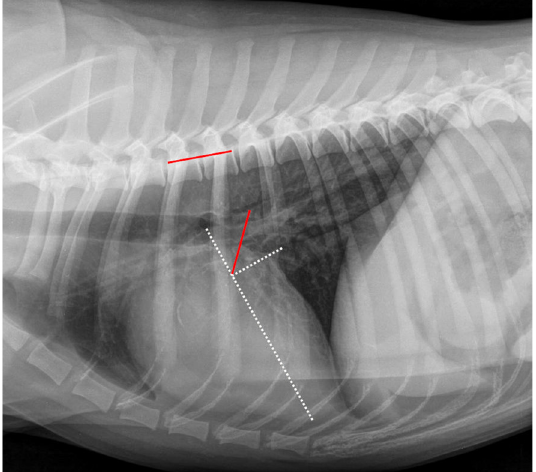
Figure 2. Measurement example of RLAD. Radiographic Left Atrial Dimension (RLAD) measurement in the same right lateral thoracic radiograph is seen in Figure 1. The long axis (white dotted line) was applied as described for the VHS measurement (Figure 1). The short axis (white dotted line) was drawn from the dorsal intersection of the caudal vena cava and the cardiac silhouette to the long axis. The bisecting RLAD line was drawn from the intersection point to the dorsal margin of the left atrium (red line on cardiac silhouette). This line was transposed onto the vertebral column (red line on vertebral) as described in Figure 1. The RLAD was 1.8 vertebral units. The LA Width was measured as described by Stepien et al. (2020) [26] and is shown in Figure 3. As a basis for measuring the RLAD, two axes had to be drawn similarly as described for the VHS. The long axis was measured for VHS and RLAD. Afterward, the LA Width line was drawn at a 90° angle at the height of the dorsal intersection between the cardiac silhouette and the caudal vena cava. This line was finally applied to the vertebral column beginning at the fourth thoracic vertebra, and the number of encompassed vertebrae was recorded as LA Width .